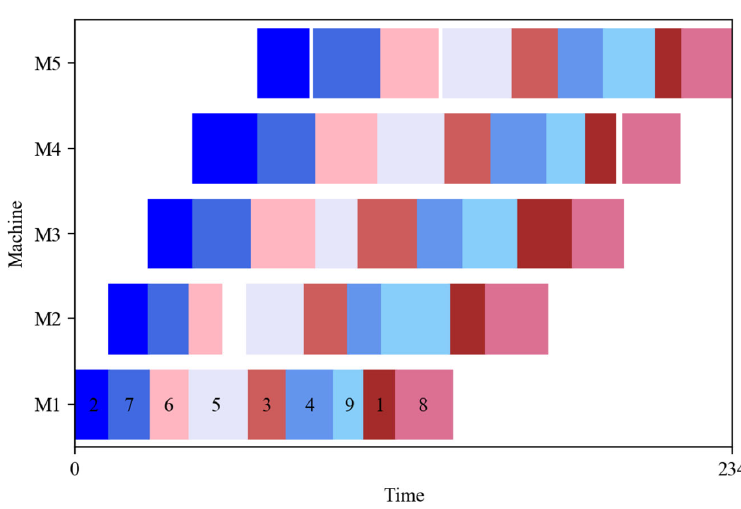
Figure 6. Gantt chart of the optimal solution based on the QL algorithm.